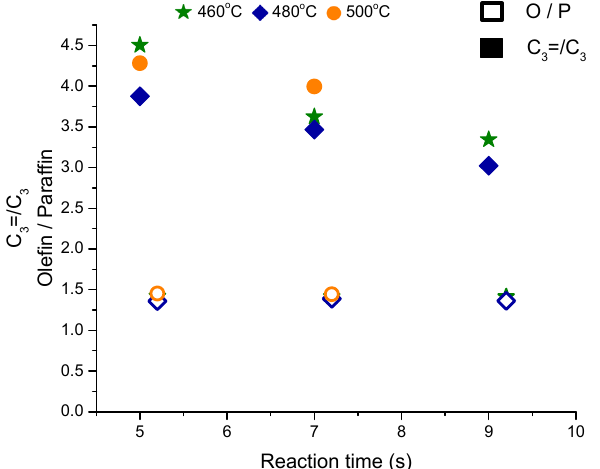
Figure 7. Average C 3 = / C 3 (with 95% confidence of ± 0.23) and Olefin / Paraffin (O/P) (with 95% confidence of ± 0.02) ratios for multiple injections on the riser simulator reactor as a function of temperature 460–500 °C and reaction time 5–9 s. O/P presented in the figure with white fill, shifted to the right for better clarity. The C 3 = /C 3 is represented by filled shape.